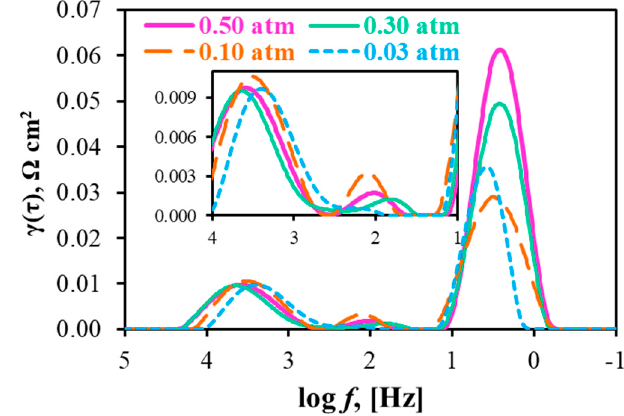
Figure A3. DRT results for the impedance spectra presented in Figure A2. Table A1. Effect of hydrogen humidification on the PCC performance at 700 °C, when p’’H 2 O = 0.50 atm. R O and R p are presented for OCV mode, while jH 2 is presented at U = 1.3 V. p’H 2 O, atm